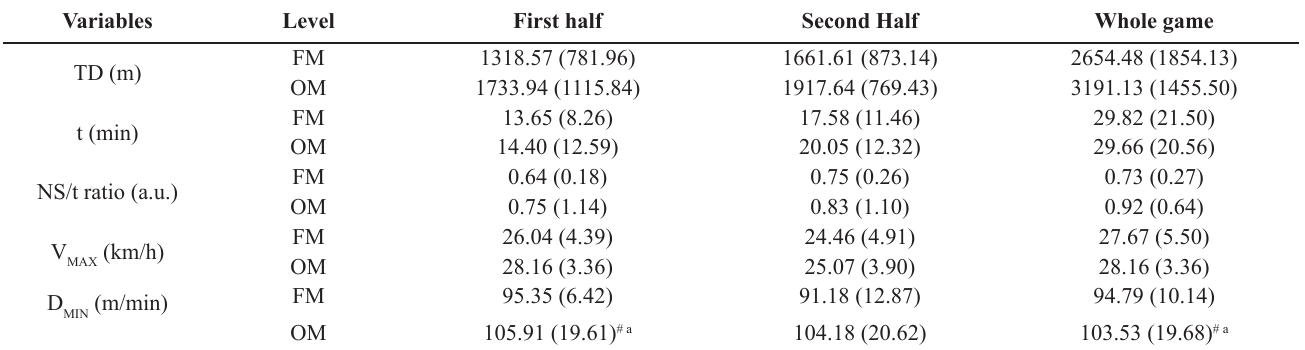
Table 1. Values of physical performance during the official match (OM) and pre-season friendly match (FM). Results are presented in medians (interquartile